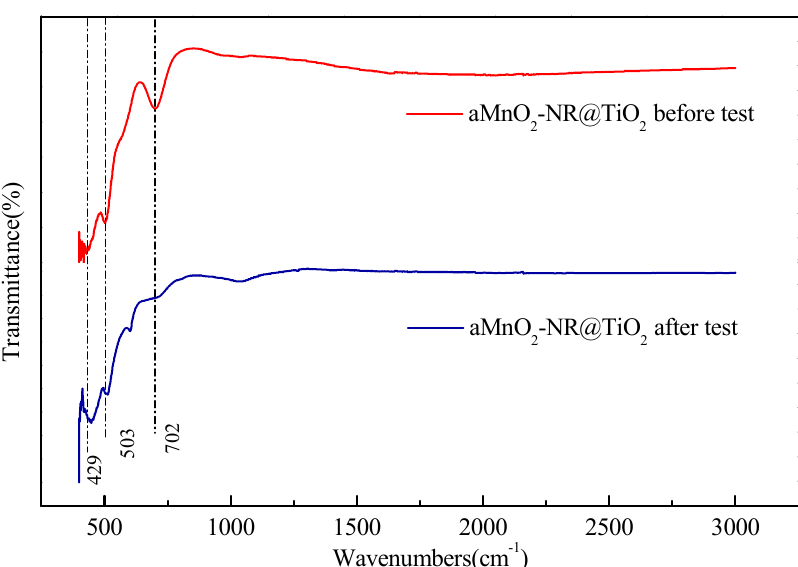
Figure 7. FTIR spectrum of αMnO 2 -NR@TiO 2 before and after test.